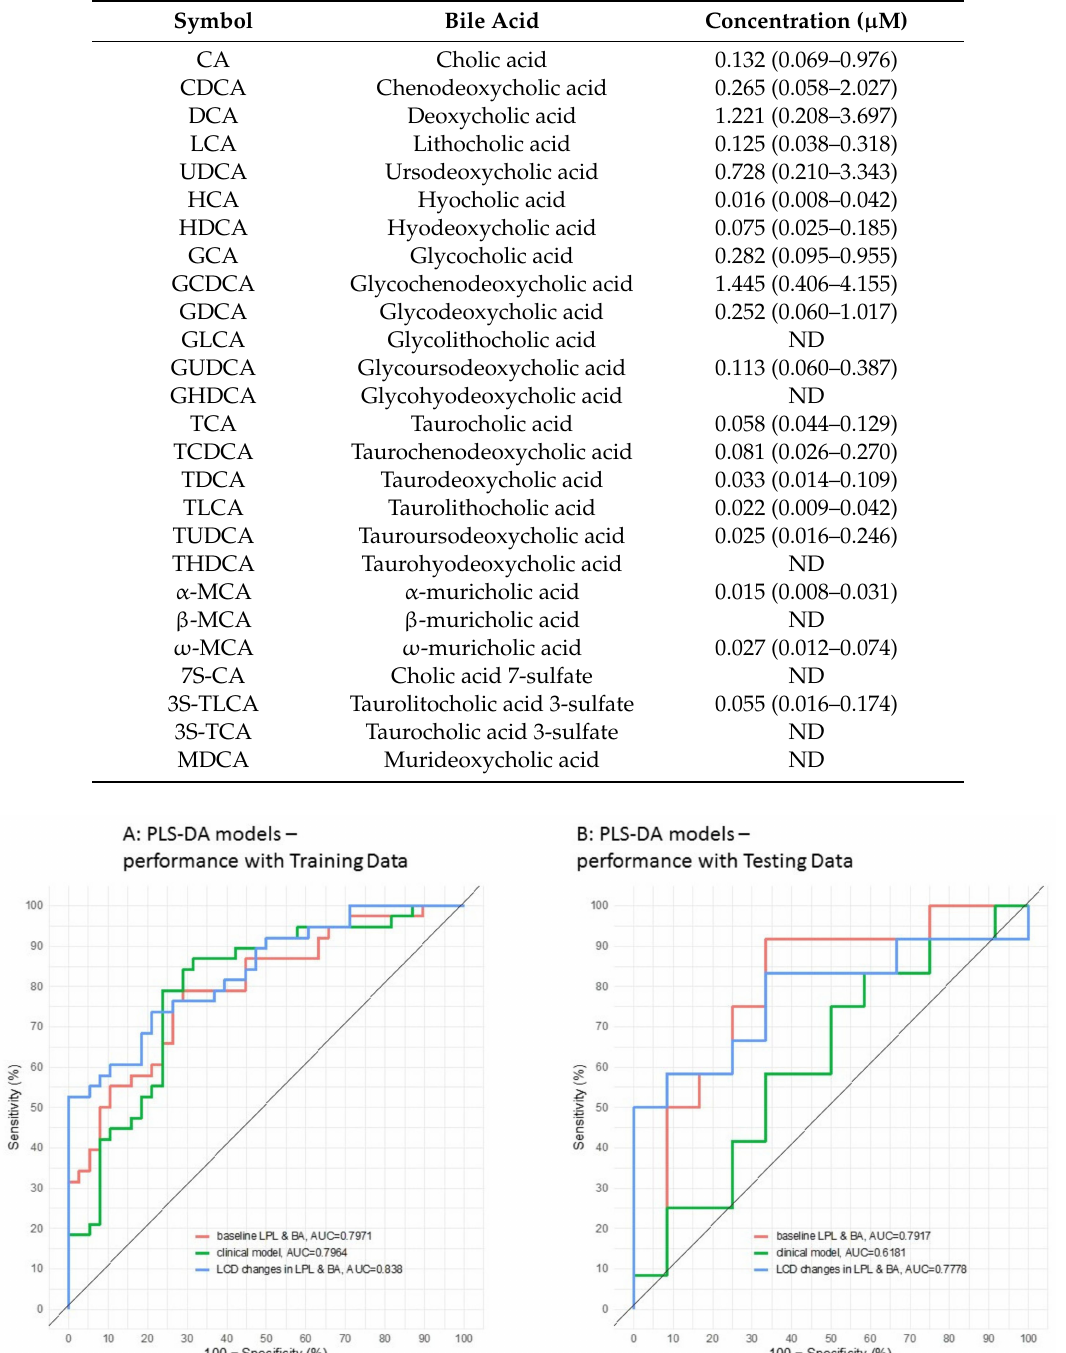
Table 2. Levels of circulating bile acids measured in the DiOGenes cohort. Results are expressed as the median (10th–90th percentiles).